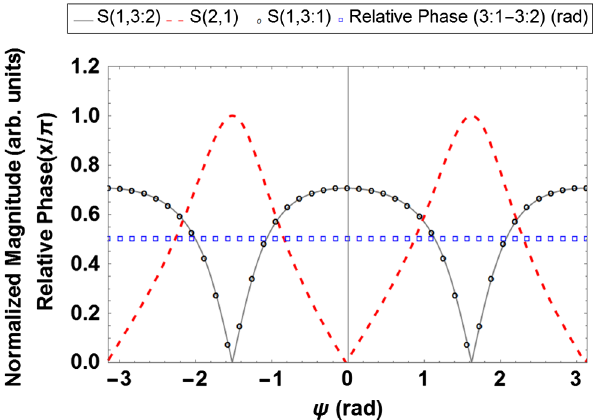
FIG. 7. S-parameters of the ideal circuit model with S 1 ð 3 ∶ 1 Þ (black-o), S 1 ð 3 ∶ 2 Þ (gray-line), S 21 (dashed-red), and the relative phase between each TE O 11 mode (blue-squares), S 11 (not shown) is zero by design for this analytic model.